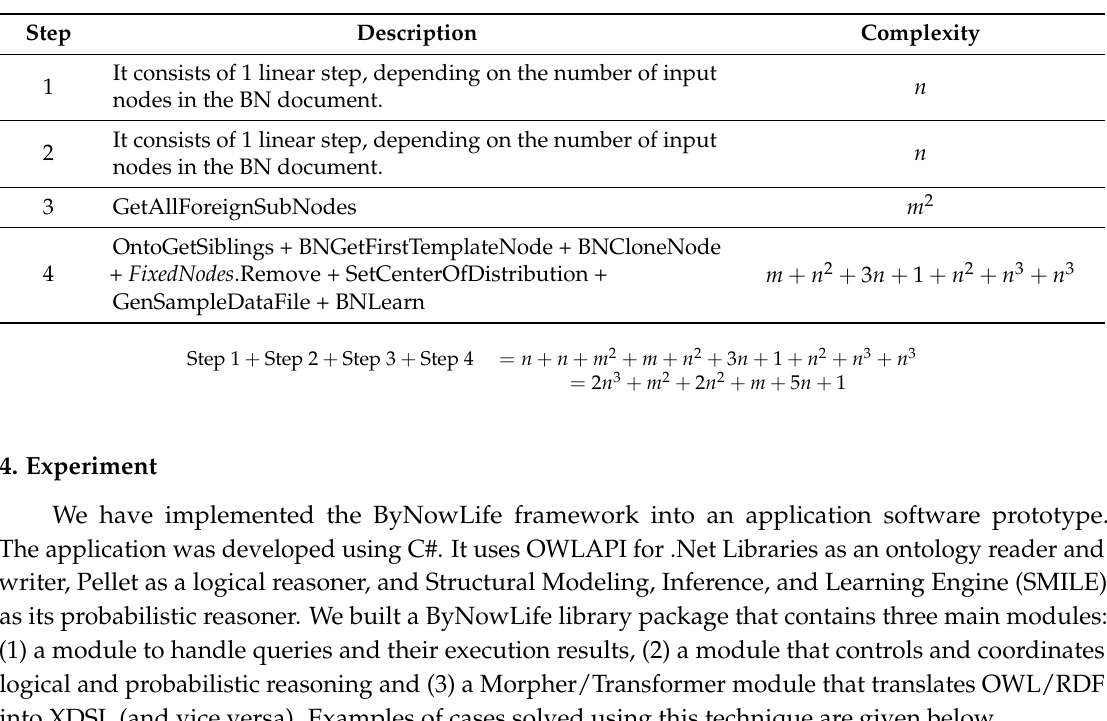
Table 4. Complexity analysis of the MergeBN